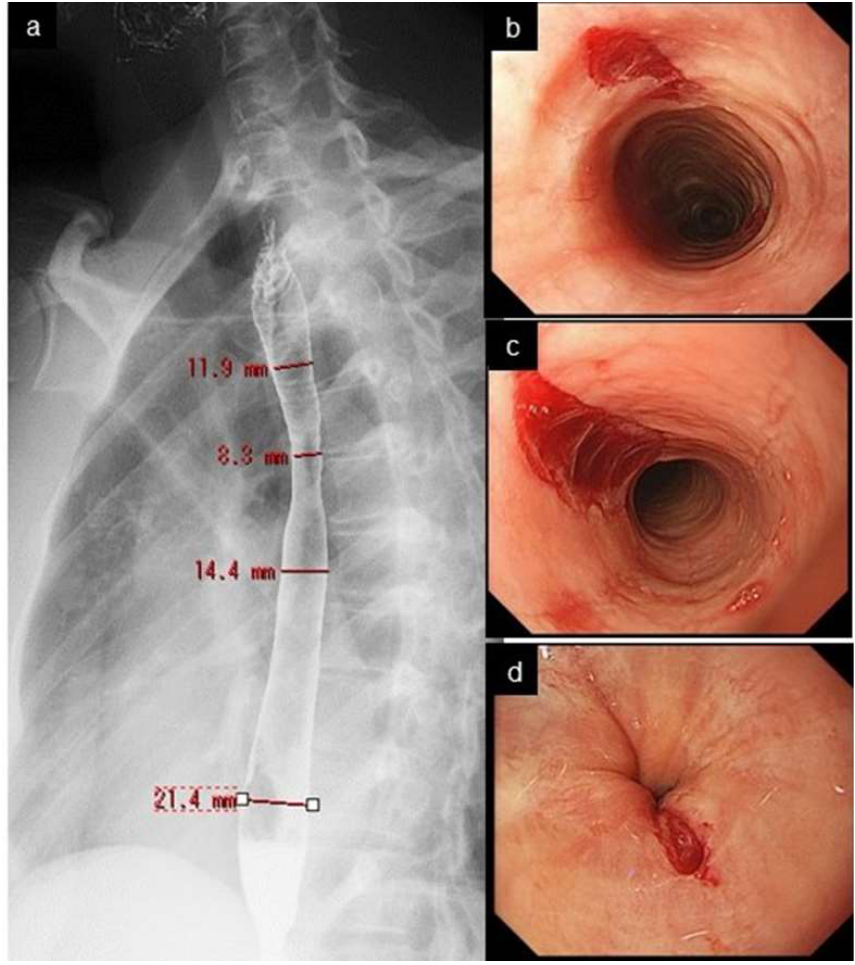
Figure 4. Narrow caliber esophagus and crepe-paper esophagus. Esophagogram shows narrow cal- iber esophagus from the upper to mid esophagus, with a diameter of 8.3 – 14.4 mm. ( a ). Mucosal